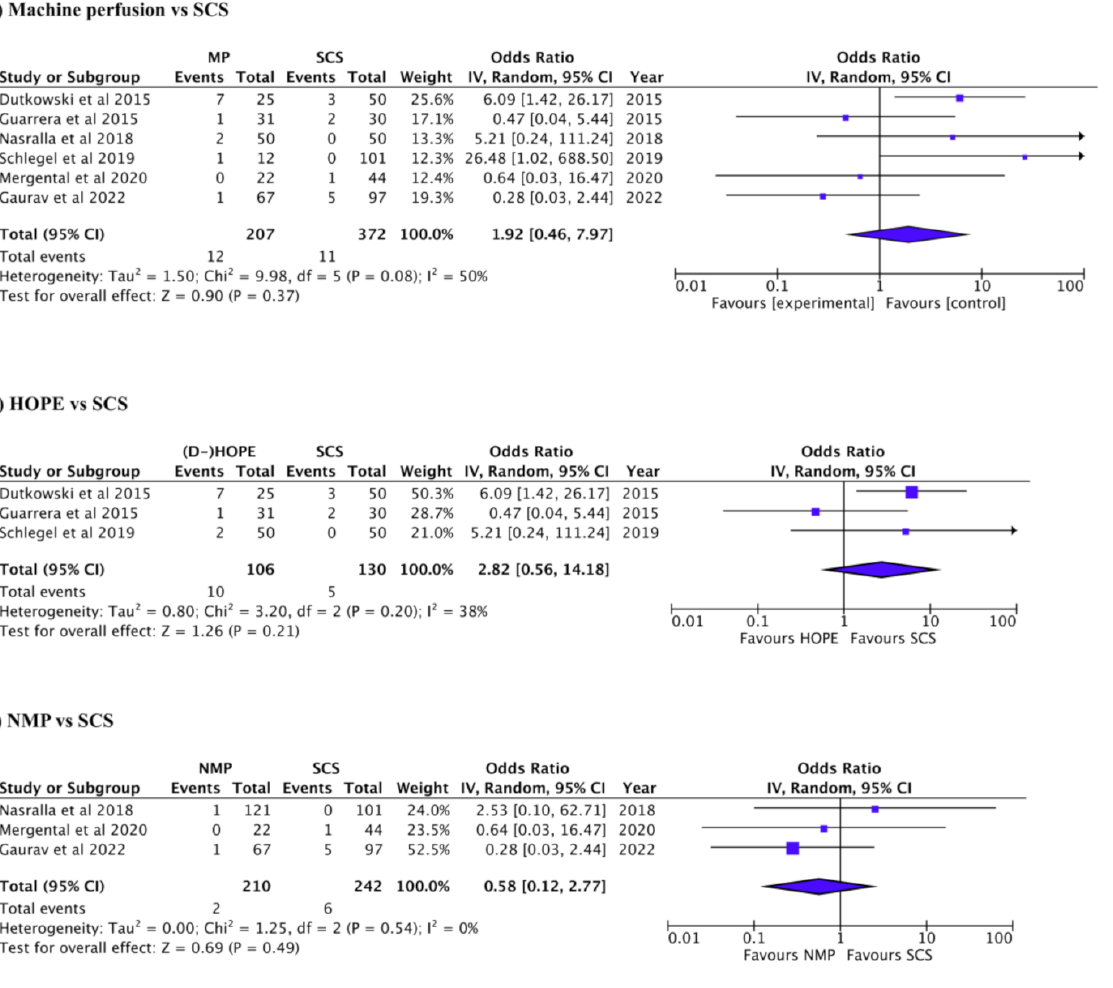
Figure 4. Forest plots for primary non-function. ( a ) Machine perfusion (hypothermic or normother- mic) vs. SCS ( P = 0.37). ( b ) HOPE vs. SCS ( P = 0.21). ( c ) NMP vs. SCS ( P =